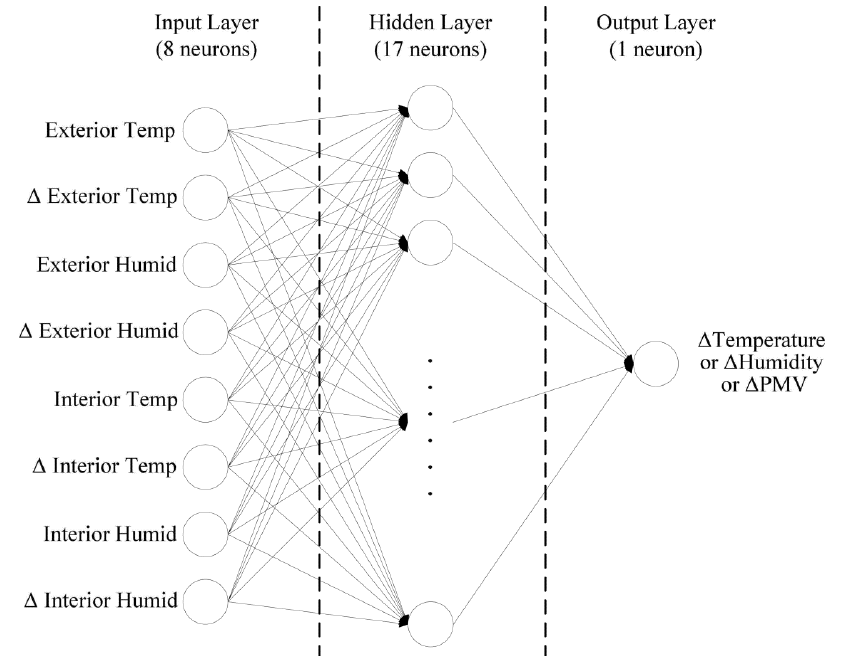
Figure 3. Structure of ANN models